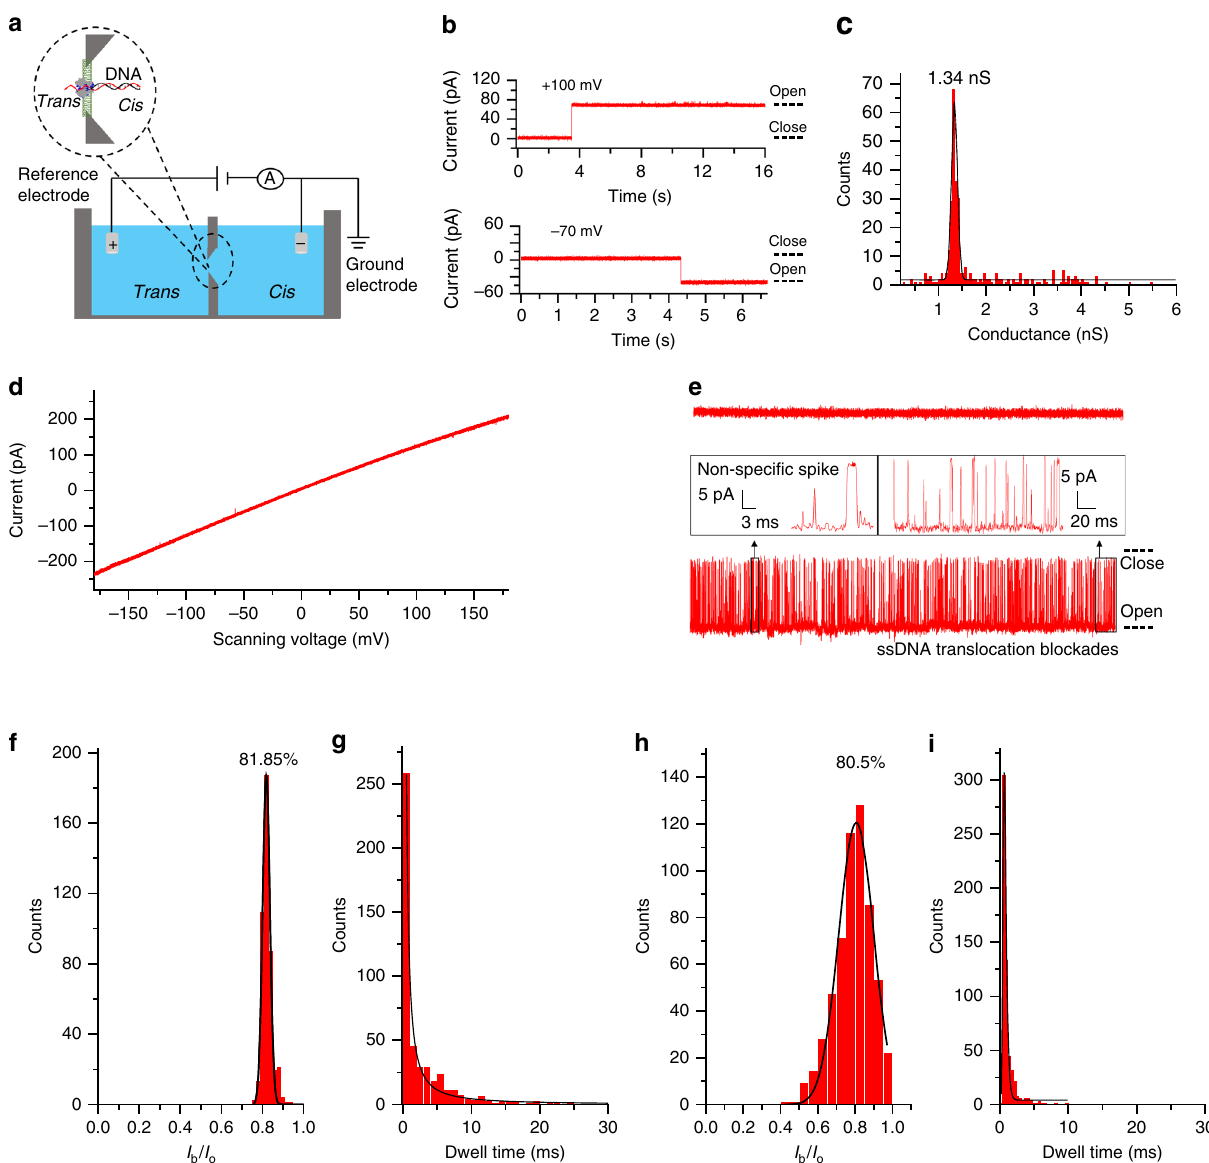
Fig. 2 Conductance assay and ssDNA translocation through the helicase nanopore in planar lipid bilayer. a The illustration of bilayer setup for single channel recording. b Current traces recording the single incorporation of the helicase nanopore into lipid bilayer. The buffer conditions were 0.5 M KCl, 5 mM HEPES, pH 7.5 and the bias voltage was + 100 mV (top) and − 70 mV (bottom). c Histogram of the conductance of the helicase nanopore in the lipid bilayer. The buffer condition was 1 M KCl, 5 mM HEPES, pH 7.5 and the bias voltage was + 70 mV ( n = 320 from 15 independent trials). d I – V curve of helicase nanopore in a ramp voltage ranging from − 180 to + 180 mV (Buffer conditions: 1 M KCl, 5 mM HEPES, pH 7.5). e Current traces of helicase nanopore in BLM without (top) and with 100 nM ssDNA (Sequence A of 48 nt, from 5 independent trials). Buffer condition: 0.5 M KCl, 5 mM HEPES, pH 7.5 under − 50 mV. f , g Histograms showing the percentage of current blockages and dwell times caused by linear ssDNA under + 50 mV (Buffer condition: 0.5 mM KCl, 5 mM HEPES, pH 7.5, n = 453 from 5 trials). h , i Histograms showing the percentage of current blockages and dwell times caused by linear ssDNA under + 100 mV (Buffer condition: 0.5 mM KCl, 5 mM HEPES, pH 7.5, n = 580 from 5 trials). Source data generating panel b to i are provided as